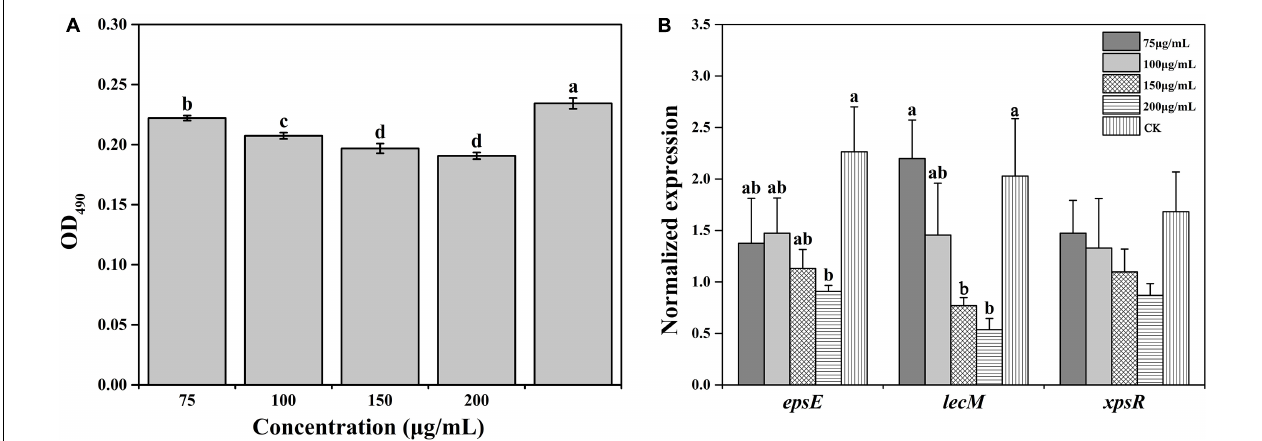
FIGURE 5 | Effect of caffeic acid on biofilm formation (A) and the expression of related genes (B) of R. solanacearum at different concentrations ranging from 75 to 200 µ g/mL. This assay was independently replicated three times, and the OD 490 value was determined at 24 h. SerC was used as the reference gene to normalize the gene expression using the 2 − (cid:77)(cid:77) Cq method. The error bars indicate the standard errors from three independent replicates, and the lowercase letters indicate significant differences identified according to Duncan’s test ( p < 0.05).